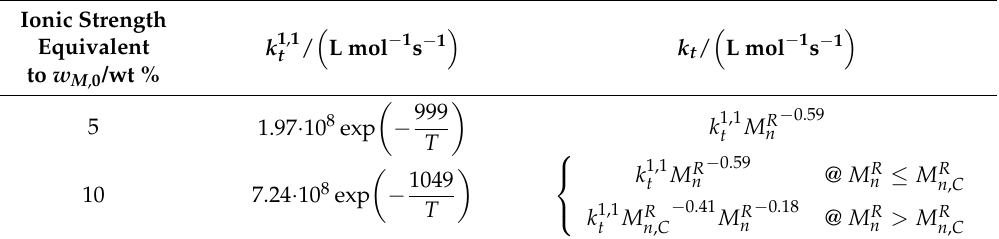
Table 5. Termination rate coefficients for the fully ionized MAA [27]. For 10 wt %, M R 80 MW MAA